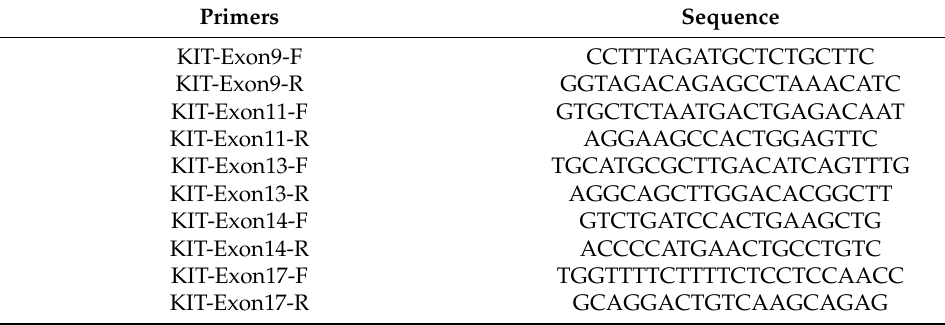
Table 1. Nucleotide sequences of primers used for Sanger